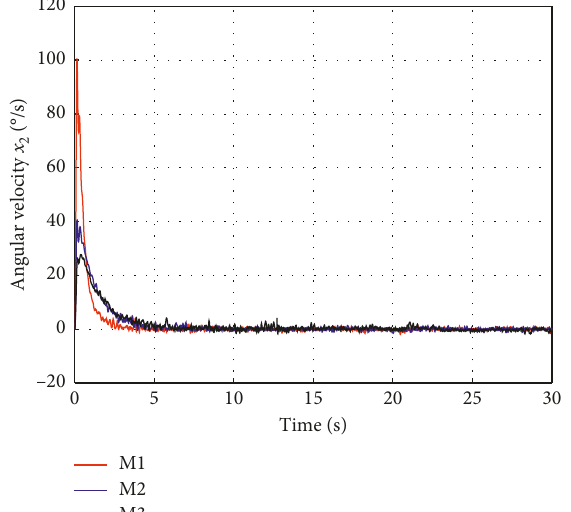
Figure 9: Time response of attitude in M1 under different initial values.